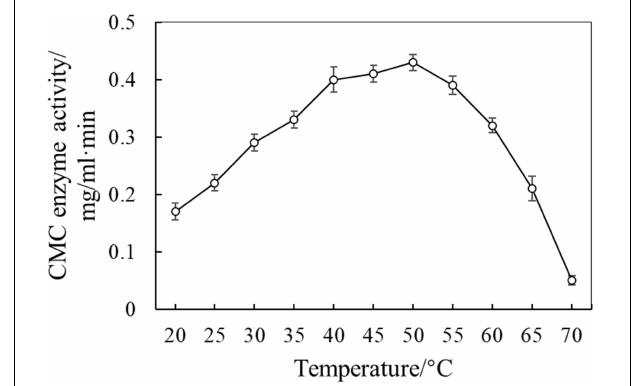
FIGURE 4 | CMC enzyme activity at different temperature